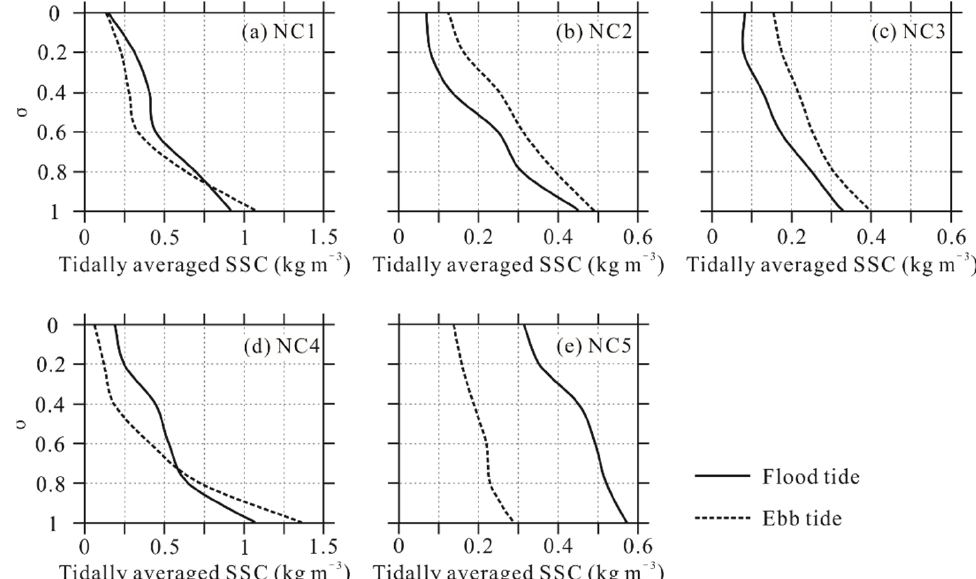
Figure 9. Vertical profiles of tidally averaged SSC (kg m − 3 ) over flood tide and ebb tide at NC1 to NC5 stations ( a – e ). Here, 𝜎 is relative depth, 𝜎 = −𝑧/ℎ ( 𝜎 = 0 is the surface and 𝜎 = 1 the bottom). At the NC2 and NC3 stations, located on the shoal, the flood tidally averaged SSC were larger than that of the ebb tidally averaged SSC. At the NC2 station, the flood and ebb tidally averaged SSC were 0.21 kg m − 3 and 0.29 kg m − 3 . At the NC3 stations, the flood and ebb tidally averaged SSC were 0.17 kg m − 3 and 0.25 kg m − 3 . At the NC2 and NC3